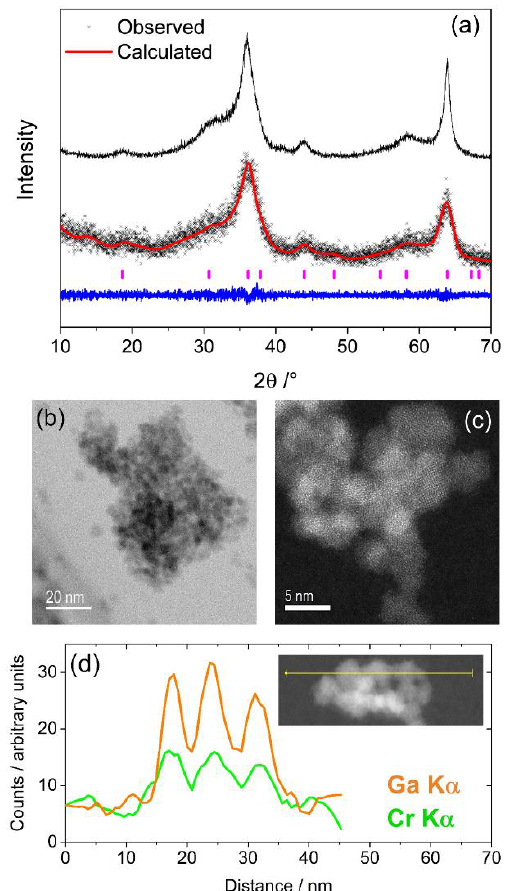
Figure 1. ( a ) Pawley refinement of the X-ray diffraction profile ( λ = 1.5406 Å) of the chromium substituted γ -Ga 2 O 3 with the pattern of pure γ -Ga 2 O 3 above as a comparison. The red line is the fitted profile, the black points the measured data and the blue ticks the positions of allowed Bragg peaks. The blue line is the difference curve. ( b , c ) High-resolution transmission electron microscopy (HR-TEM) images of a region of the sample at two magnifications. ( d ) Energy dispersive X-ray spectroscopy (EDS) line-scan over three crystallites showing the homogeneous distribution of the two metals.